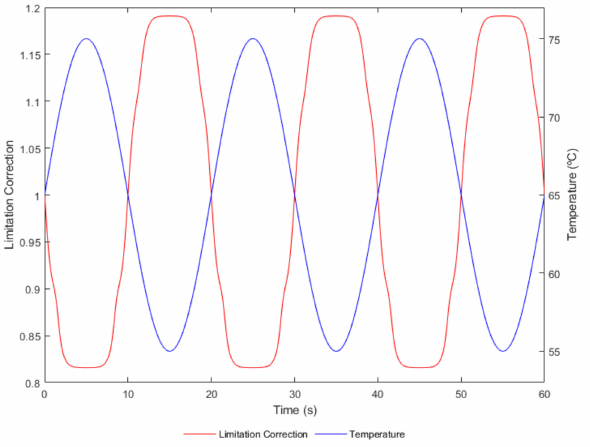
Figure 9. Surface associated with the wind– merge